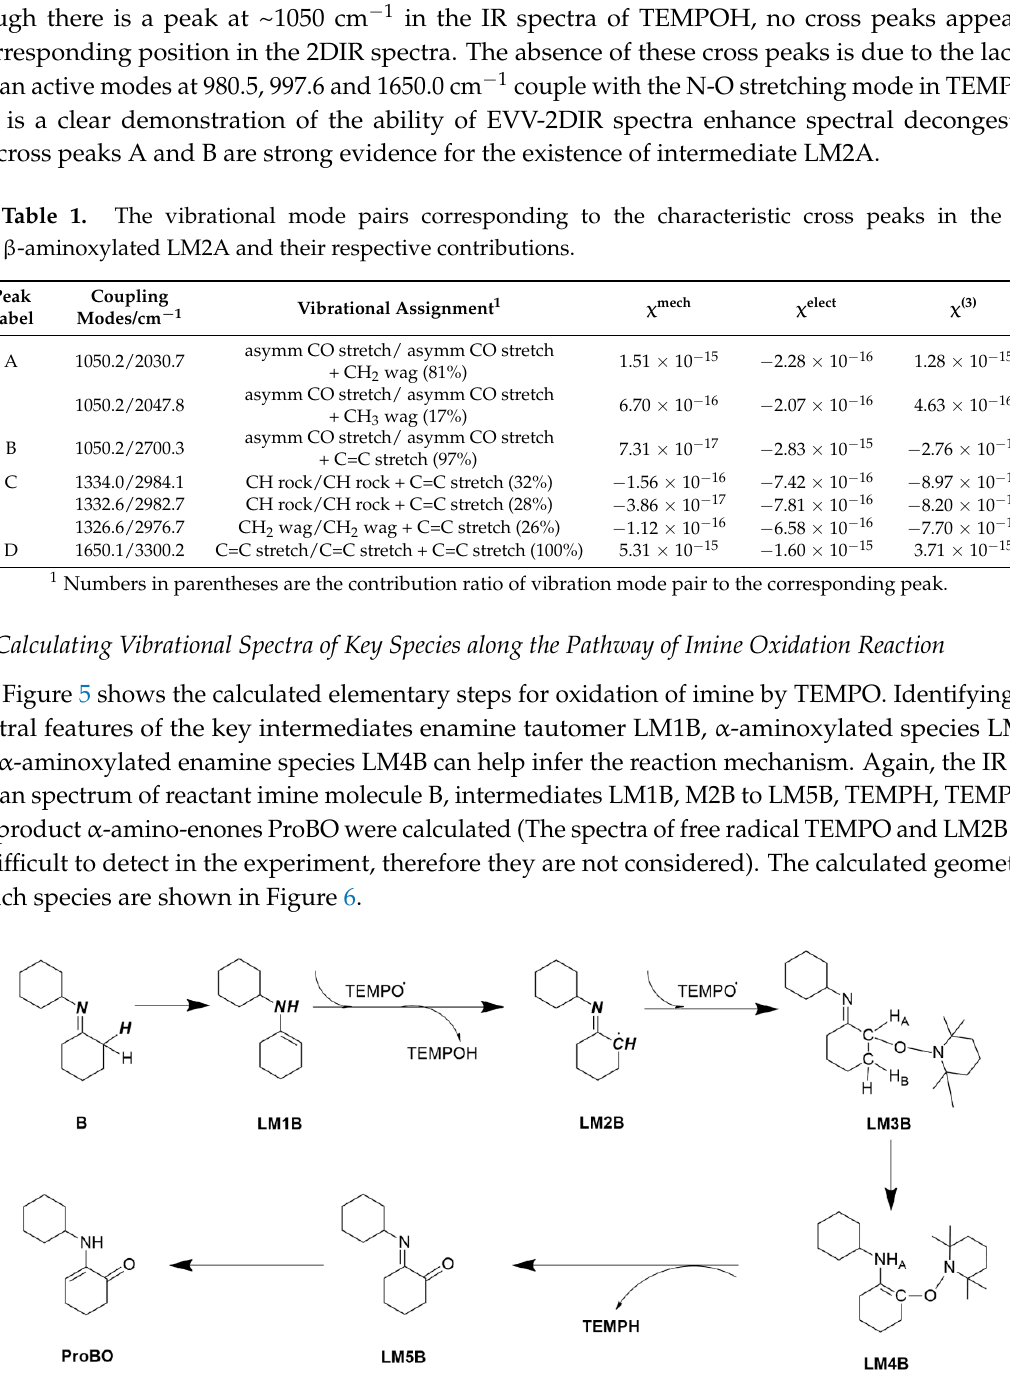
Figure 5. Calculated elementary steps for oxidation of imine molecule B by TEMPO.